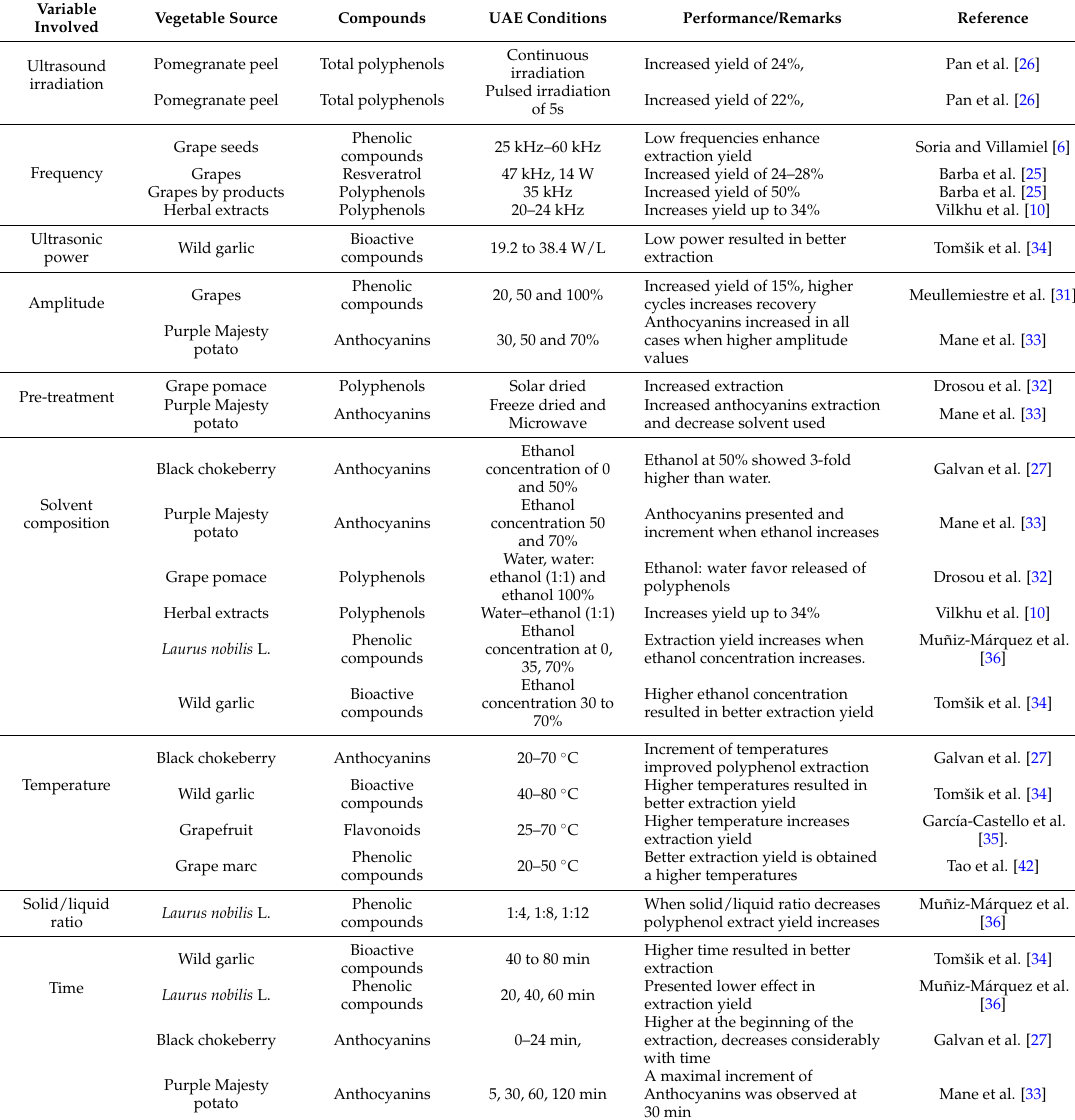
Table 3. Effect of involved variables of Ultrasound Assisted Extraction (UAE) in polyphenols extraction yields from different vegetable